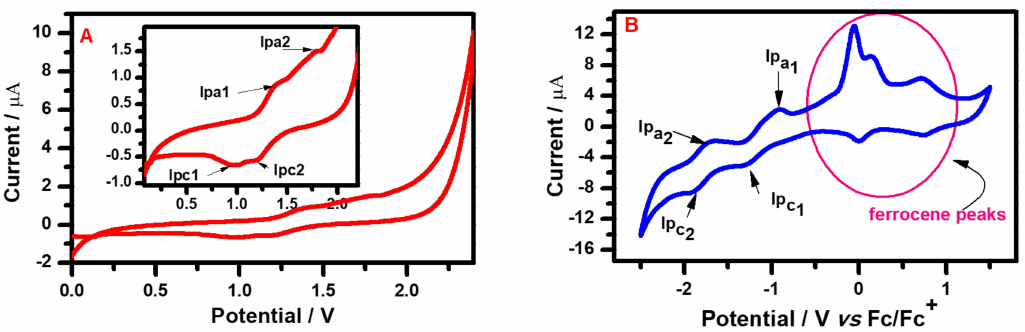
Figure 5. Cyclic voltammogram of G1PPT-co-P3HT in acetonitrile containing 0.1 M Bu 4 NPF 6 at scan rate 50 mV/s using Ag/AgCl reference electrode ( A ) and versus Ag/Ag+ reference electrode in ferrocene ( B )